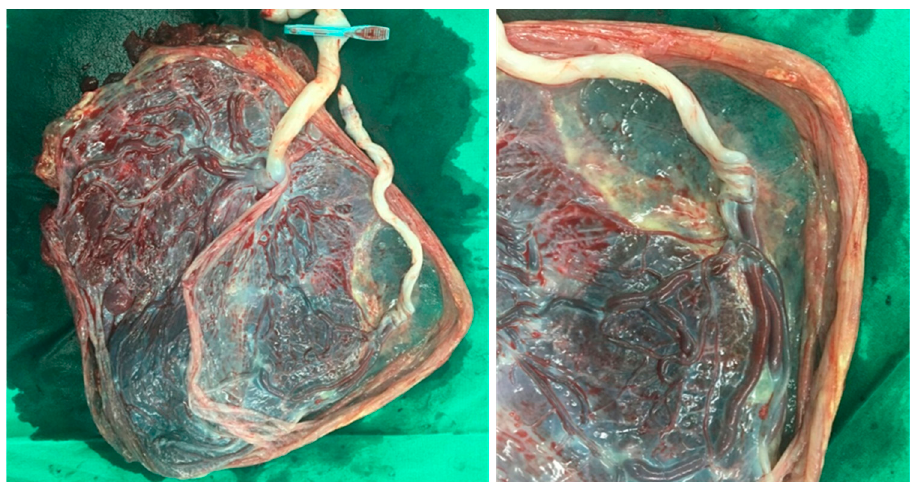
Figure 2. Photograph showing the placenta with a velamentous insertion of the umbilical cord in monochorionic twin pregnancy.